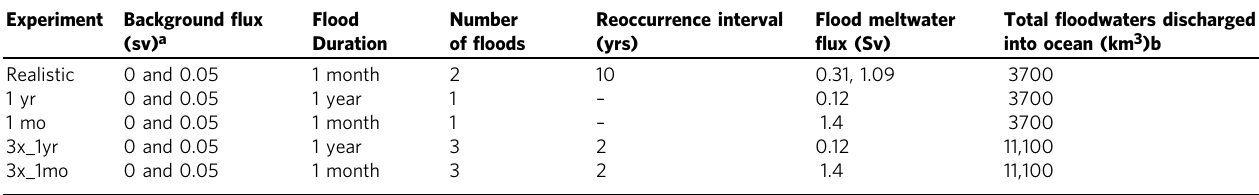
Table 1 Design of fl ood perturbation